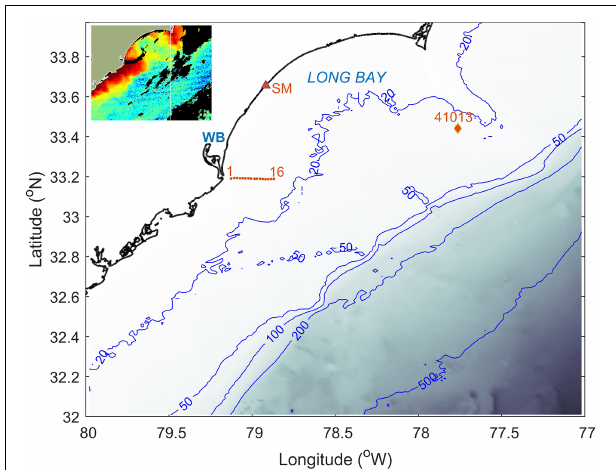
FIGURE 2 | Study area showing the data collection stations 1–16 (asterisks), NOAA NDBC buoy 41013, and the NOAA tide gauge station Springmaid Pier (SM). Isobaths are shown in meters. Inset is the satellite image (the same property and color scale as in Figure 1 ) corresponding to the map area and obtained on March 11, 2020 at 16:53–18:41. Images adapted from NOAA Coastwatch/Oceanwatch.